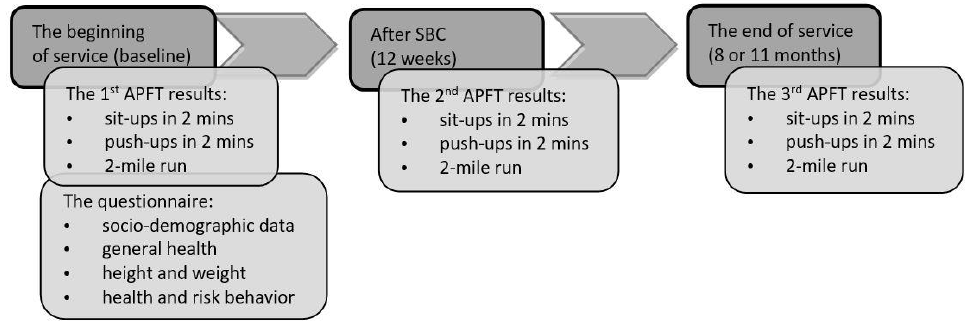
Figure 1. The data collection during military service (SBC—Soldier’s Basic Course; APFT—Army Physical Fitness Test).